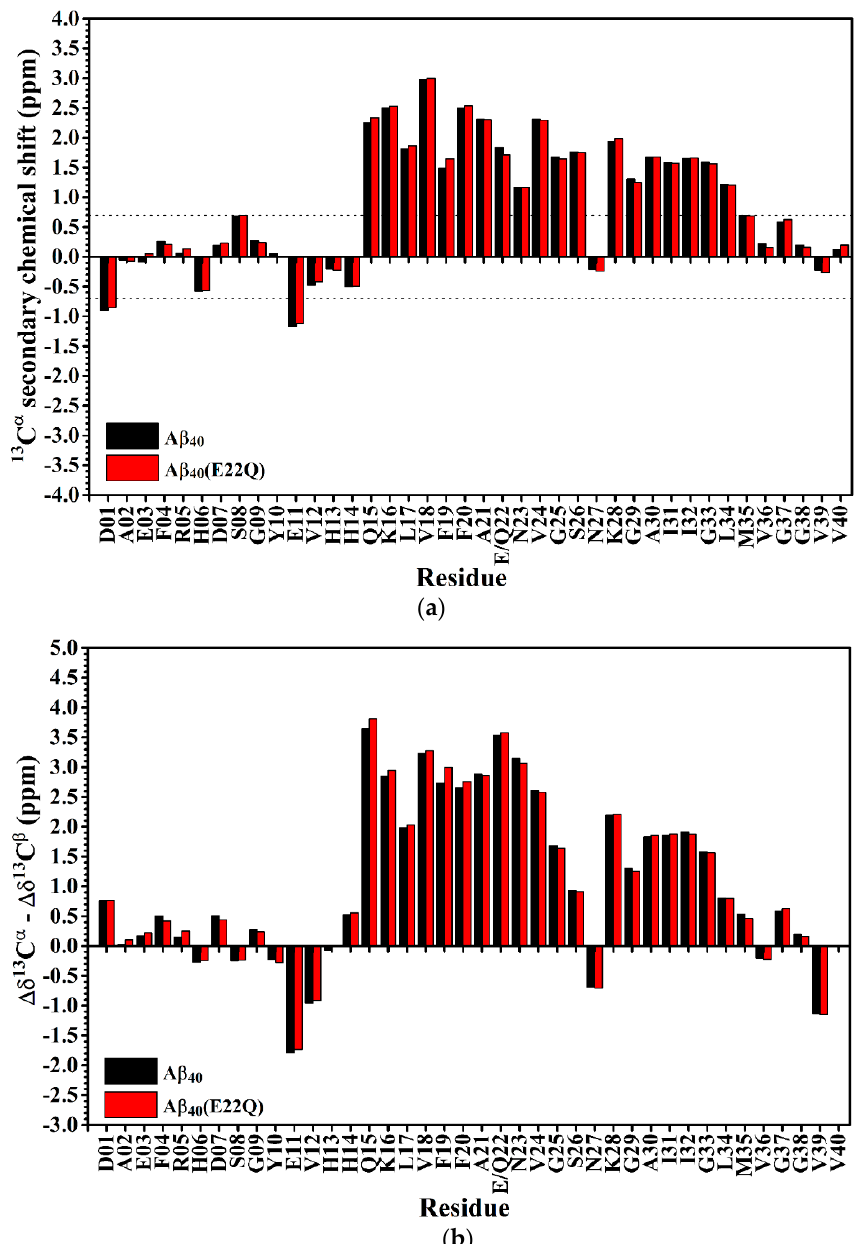
Figure 3. ( a ) 13 C α secondary chemical shifts of wild-type A β 40 (balck) and A β 40 (E22Q) (red) plotted as a function of residue. In principle, if the 13 C α secondary chemical shift of an amino acid residue is greater than 0.7 ppm, its conformation would be α -helical [35]; ( b ) Differences between Δδ 13 C α ( 13 C α secondary chemical shift) and Δδ 13 C β ( 13 C β secondary chemical shift) of wild-type A β 40 (black) and A β 40 (E22Q) (red) plotted as a function of residue. Δδ 13 C α (or Δδ 13 C β ) was defined as the difference between the observed 13 C α (or 13 C β ) chemical shift of an amino acid residue and its 13 C α (or 13 C β ) chemical shift in a random coil conformation. If Δδ 13 C α – Δδ 13 C β for an amino acid residue is positive, its conformation would be α -helical. For a more detailed description of the relationship between the value of Δδ 13 C α – Δδ 13 C β and secondary structure of an amino acid residue please see the reference [34].